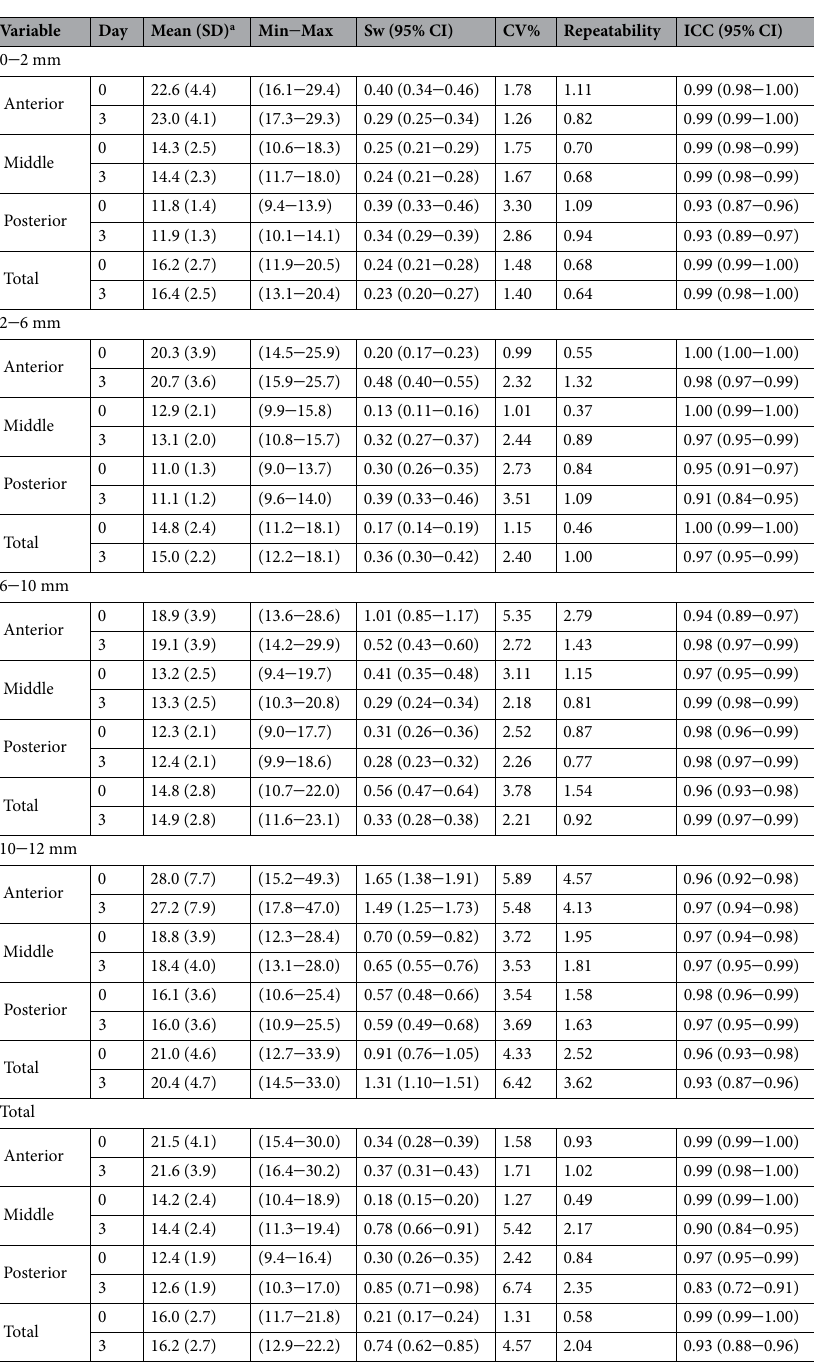
Table 2. Descriptive statistics and repeatability of measurements on Day 0 and Day 3 in healthy controls. a Subject mean. The values are presented in greyscale units. Standard deviation (SD), S standard deviation, CI (confidence intervals), CV% (coefficient of variation), ICC (Intraclass correlation